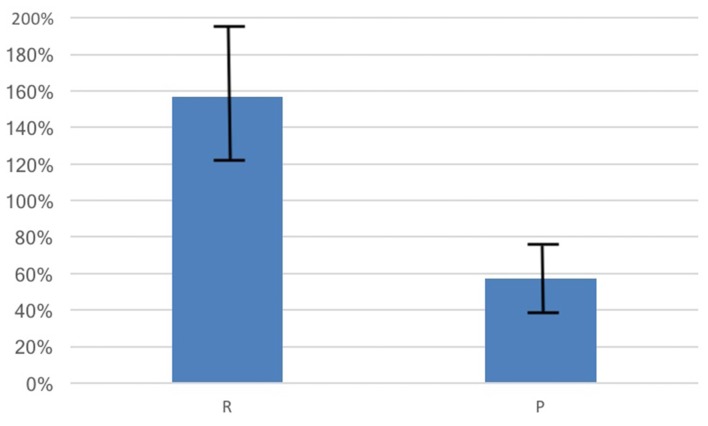
OT increased from baseline due to social interactions by 157% for those in therandomly-formed group (R) while participants in the previously-formedgroup (P) had an OT increase of 57%. The change in OT for the R group is significantly larger than for the P group (p = 0.012). Bars shown are standard errors.